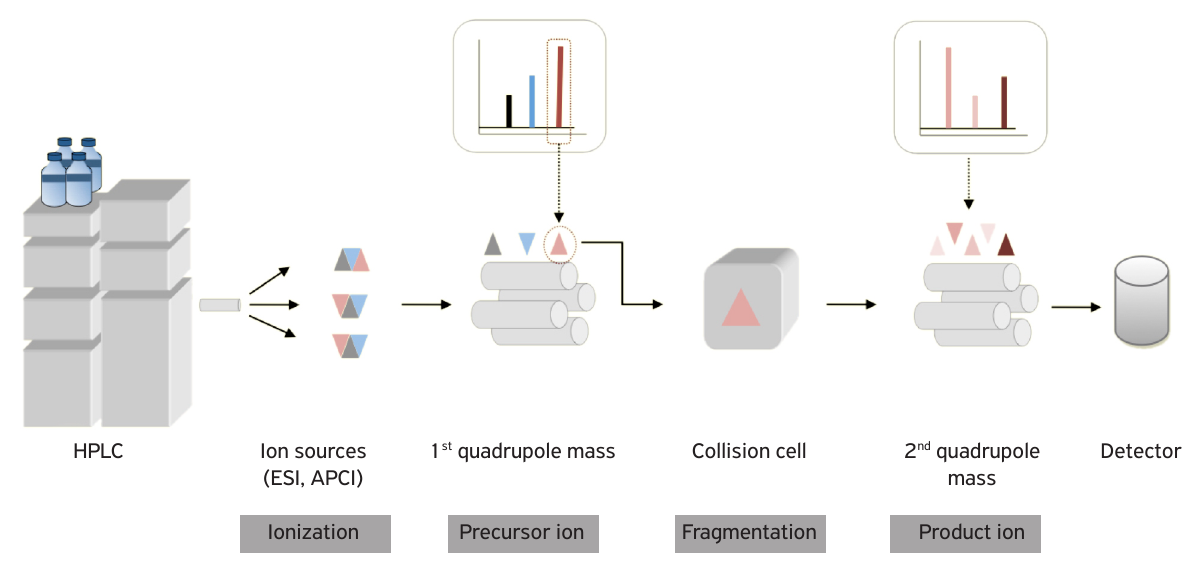
HPLC: High performance liquid chromatography; ESI: Electro-spray ionization; APCI: Atmospheric pressure chemical Figure 2. Scheme of the basic components of a triple quadrupole mass spectrometry.